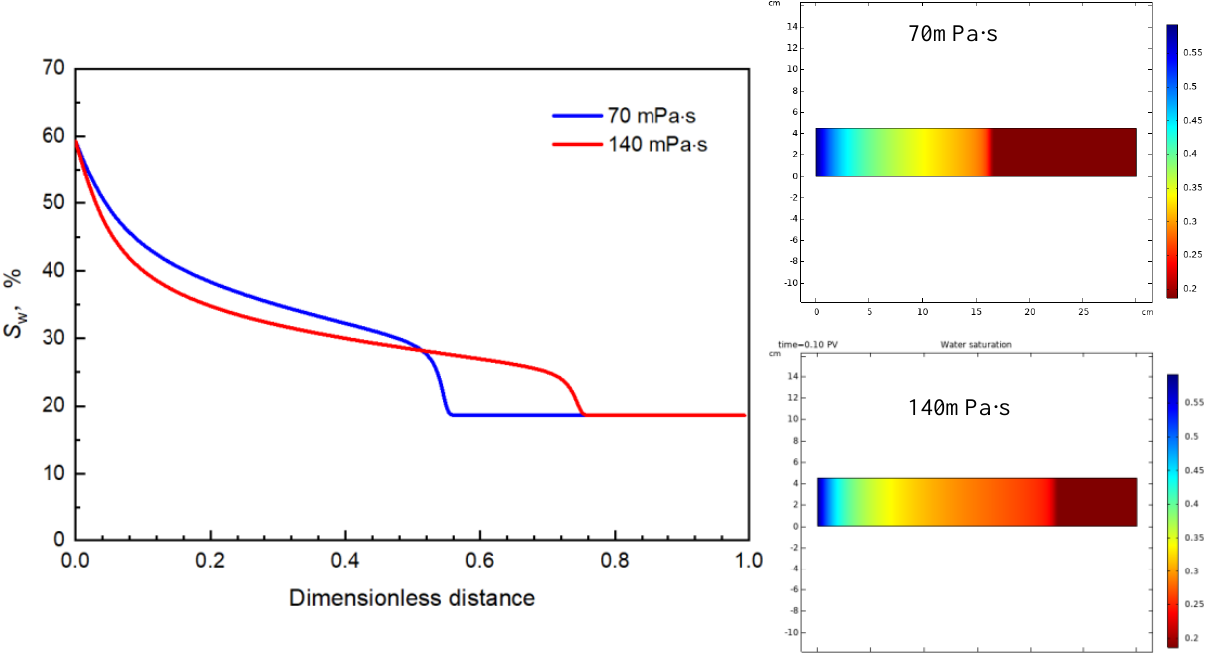
Figure 21. Water saturation distribution along the flow under different oil phase viscosity condi- tions.